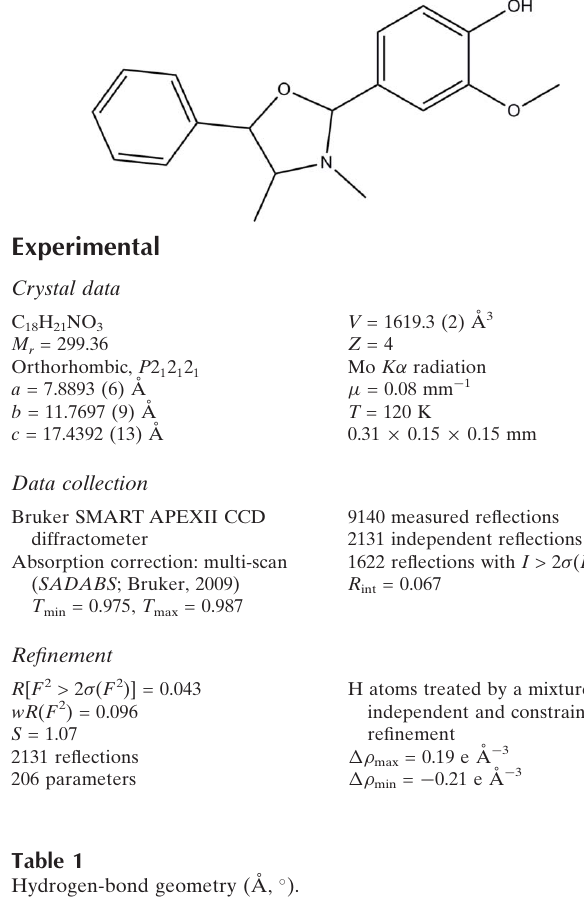
Hydrogen-bond geometry (A˚ , (cid:2)